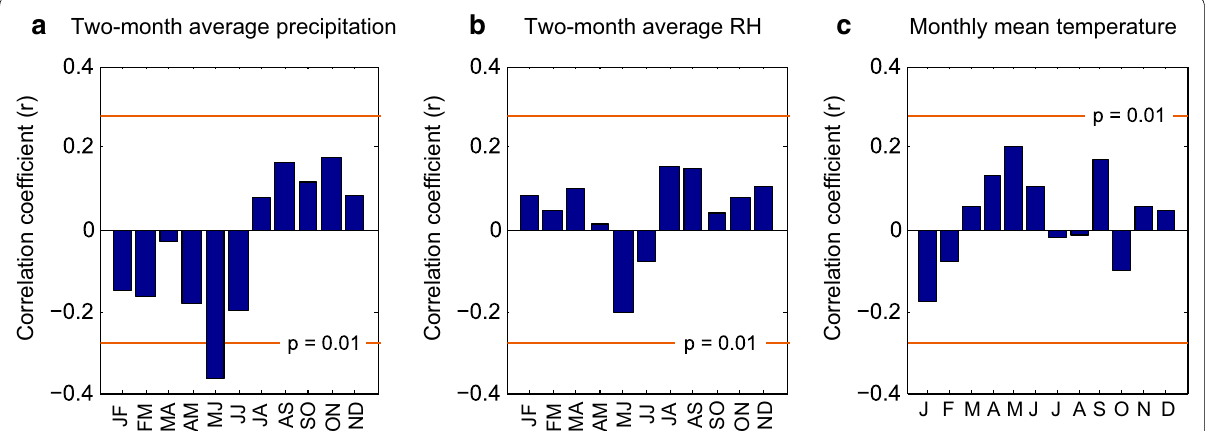
Fig. 2 Correlation between tree-ring δ 18 O and a 2-month average precipitation, b 2-month average relative humidity (RH), c monthly mean tem- perature in Sendai. Red lines indicate the significant level 99%. J January, F February, M March, A April, M May, J June, J July, A August, S September,